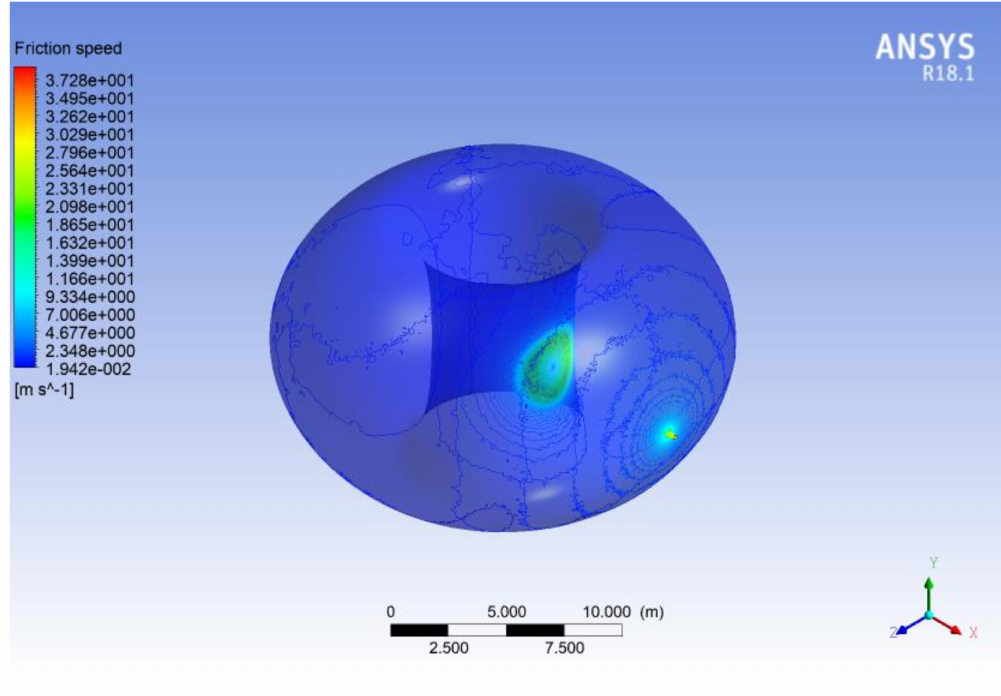
Figure 8. Friction speed at 7 × 10 − 2